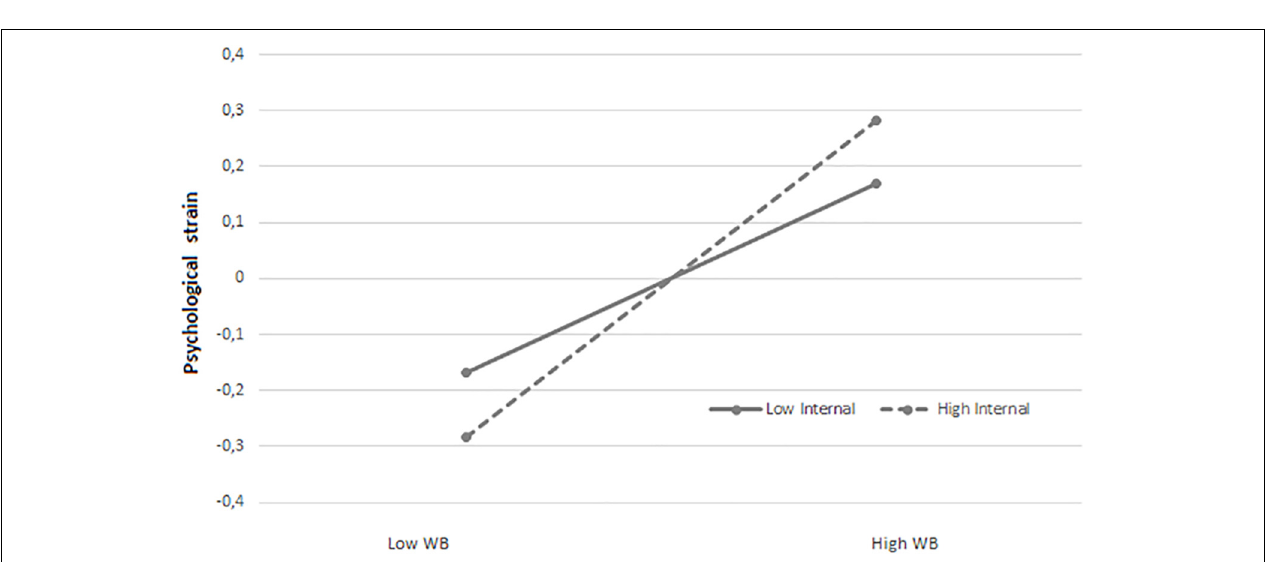
FIGURE 3 | The interaction effect of workplace bullying and internal locus of control on psychological strain. Low = 1 SD below the mean. High = 1 SD above the mean. WB = workplace bullying. Internal = internal locus of control.